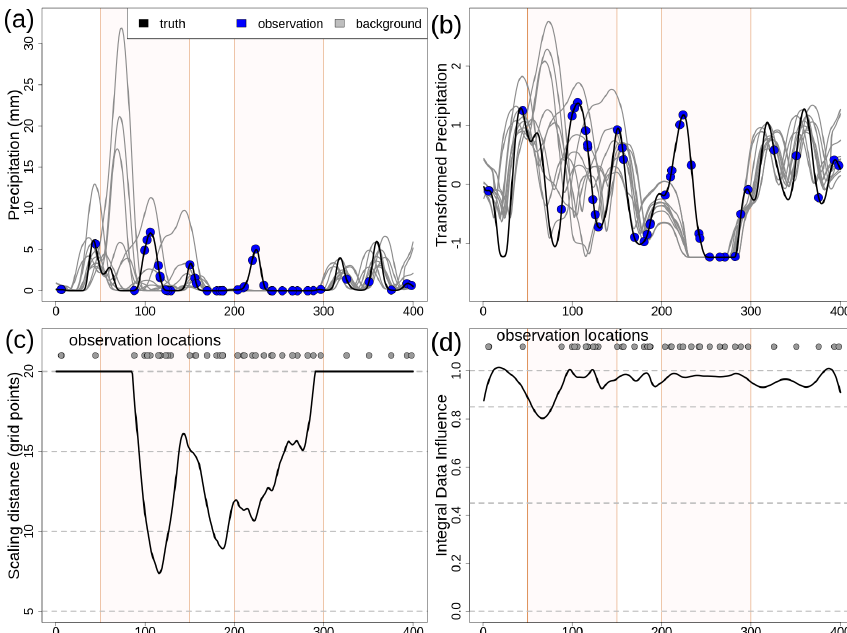
Figure 1. One-dimensional simulation. (a) Precipitation (in millimeters) – truth (black line), observations (blue dots), and background (gray lines). (b) Transformed values. (c) Reference length scale for the scale matrix D i (units u, as defined in Sect. 3.1). D i is bounded within 3 and 20u. (d) Integral data influence (IDI) based on D i from (c) . The two regions, R1 and R2, have been highlighted with different shading in the background of each